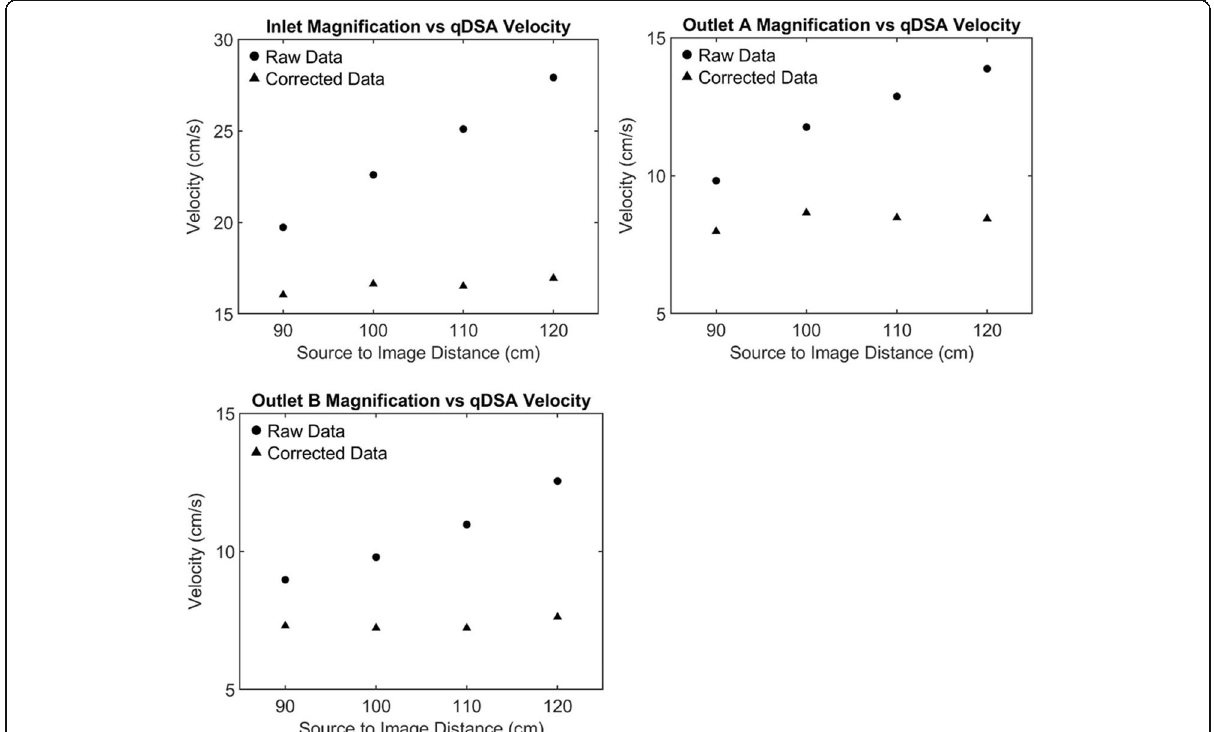
Fig. 4 The raw qDSA velocity calculations as a function of source to image distance (SID) are plotted as circles. As the SID increases the magnification factor increases causing the calculated velocity values to increase as a function of magnification. Applying the magnification correction, using a reference object, reduces variation in the calculated velocity over a range of